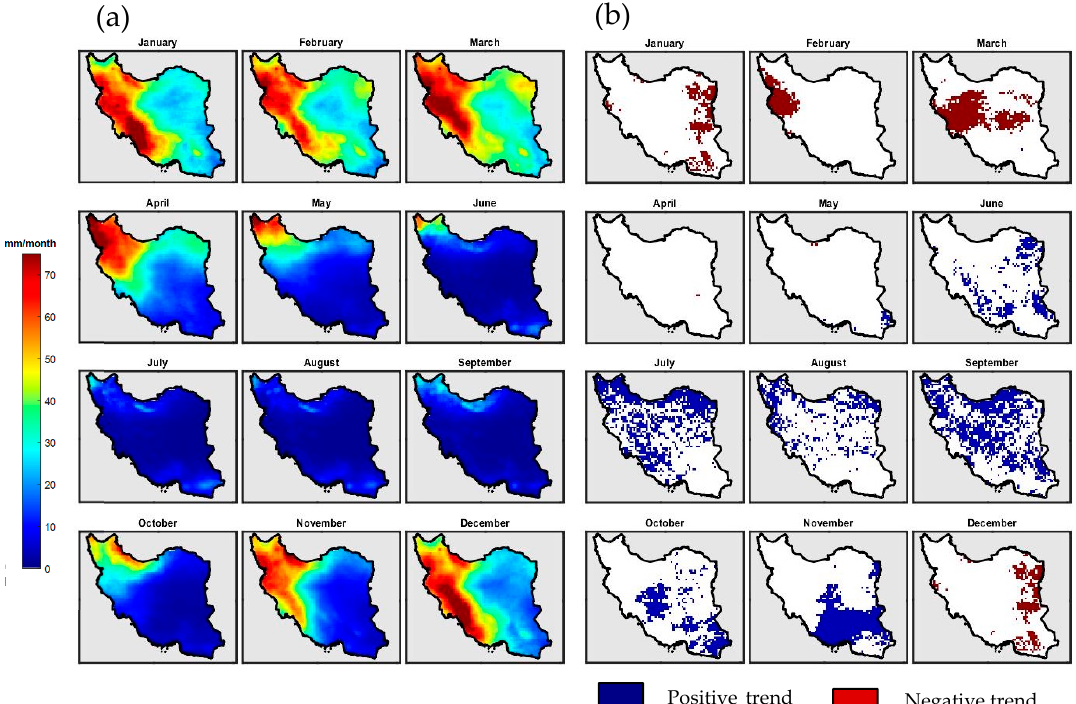
Figure 6. ( a ) Average of monthly precipitation amount; ( b ) monthly trend analysis, blue and red part represent the positive and negative trend, respectively.